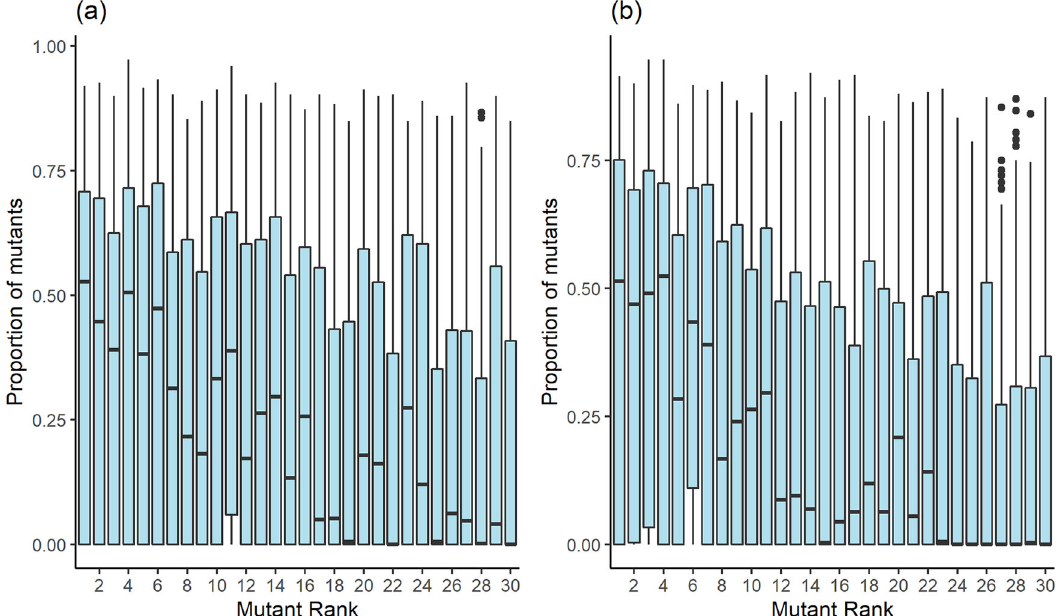
Fig. 1 Boxplots of total mutants ’ proportion in fi nal population as a function of original mutant female ’ s rank. a Scenario I — no male rank; b Scenario II — male ’ s rank affects death probability. Rank 1 corresponds to highest rank. Population size in all simulations is 300. Each simulation consists of 3000 iterations. 3000 simulations were run for each scenario, 100 simulations for each female ’ s rank. Boxplots show the interquartile range (box), median (black line), median± 1.5 IQR (error bars), and outliers (dots).